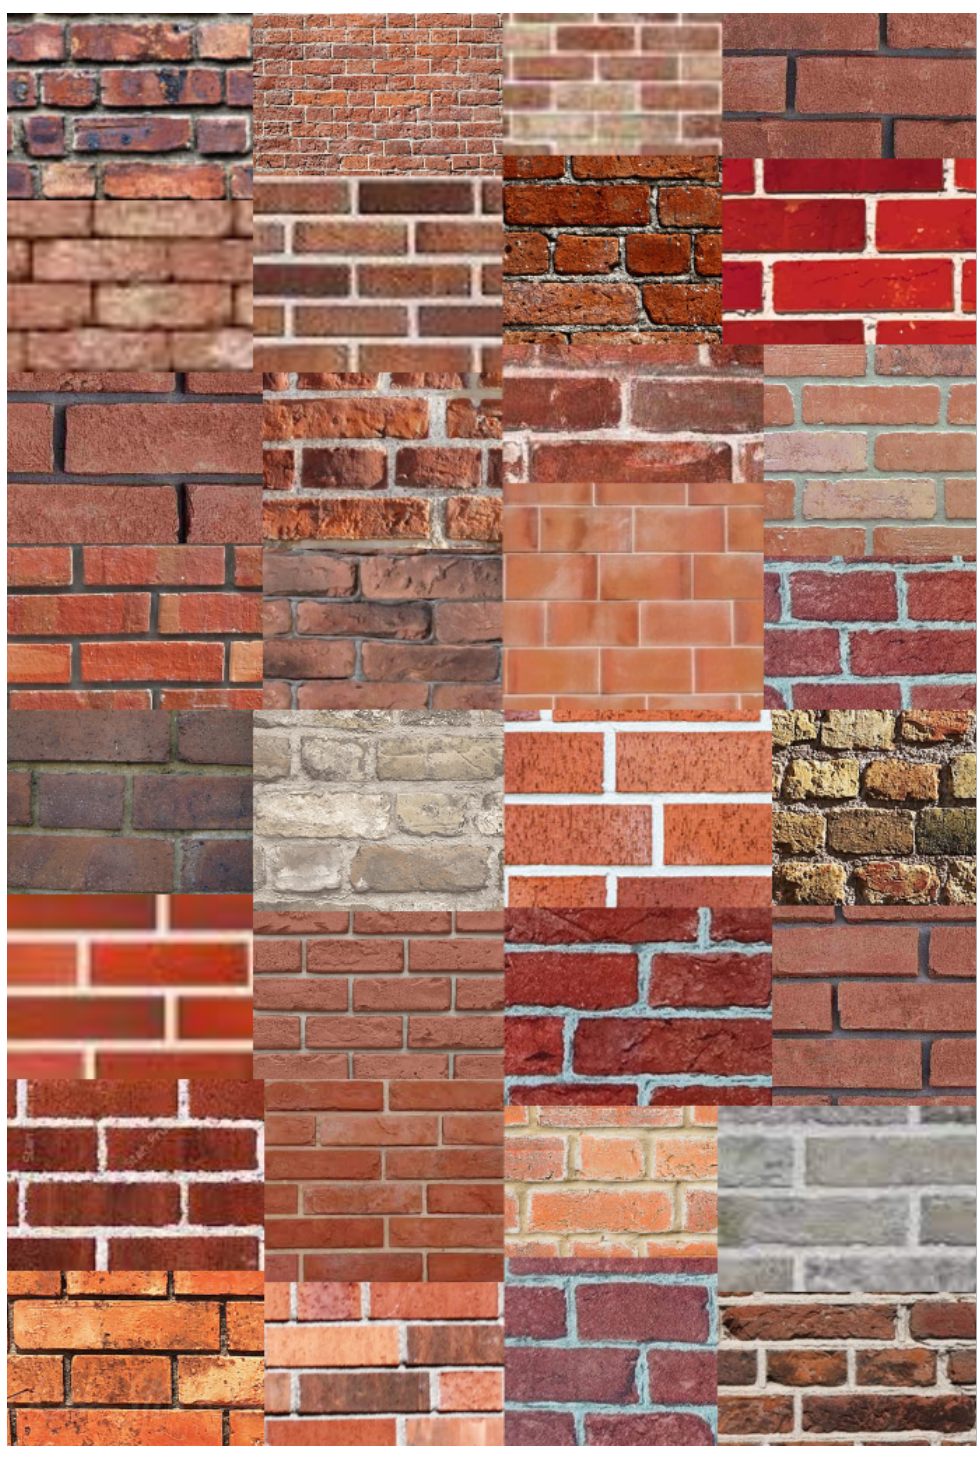
Figure 3. Illustration of some images found on Google which were labeled